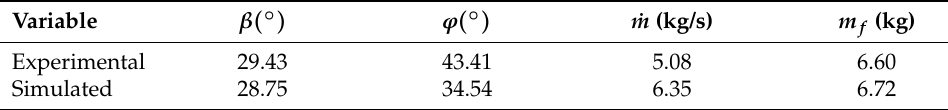
Table 8. Validation of the calibration of friction